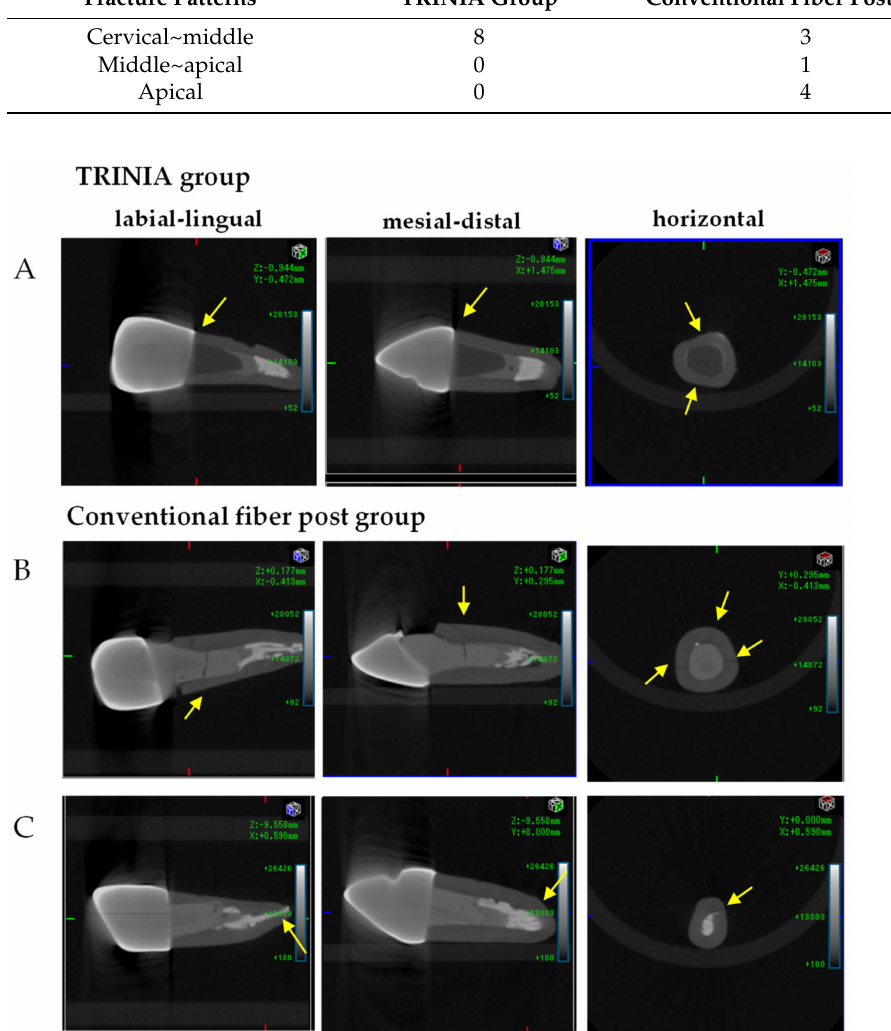
Figure 4. Micro-CT images of the bovine roots restored with fiber-reinforced post-cores and zirconia crowns. In the TRINIA group ( A ), all the specimens were fractured in the cervical and middle areas. In the conventional fiber post group, 37.5% of fractures occurred in the cervical and middle areas ( B ), and 50% were in the apical area ( C ). Arrows indicate